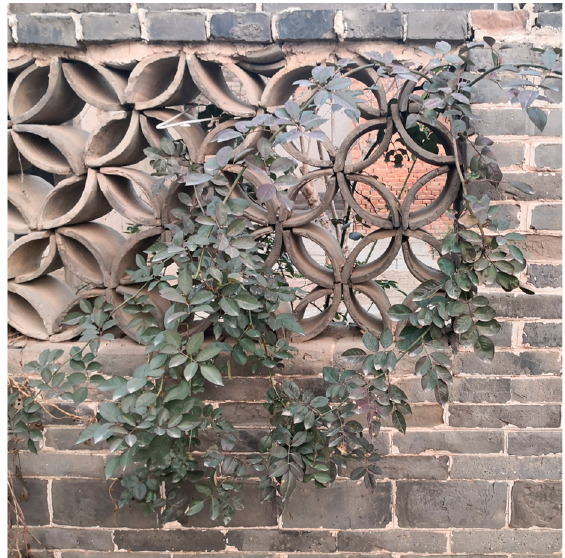
Figure 7. Tile wall decorations. Photo by W. Rong.